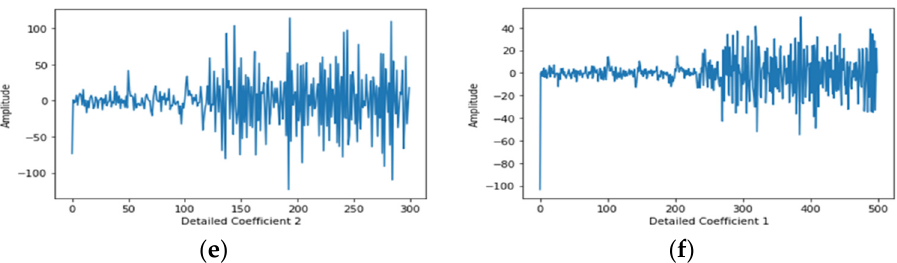
Figure 1. Shows all coefficients of five levels of DWT over experimental EEG signals. ( a ) shows the approximate coefficient, and ( b – f ) shows other detailed coefficients of DWT level 5.